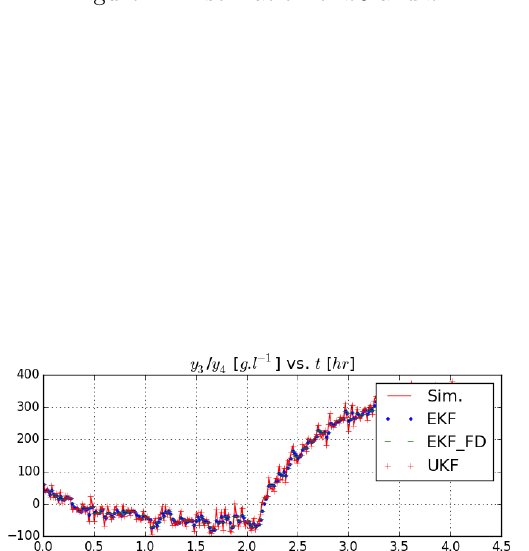
Figure 12: Estimation of z 0 and z 1.